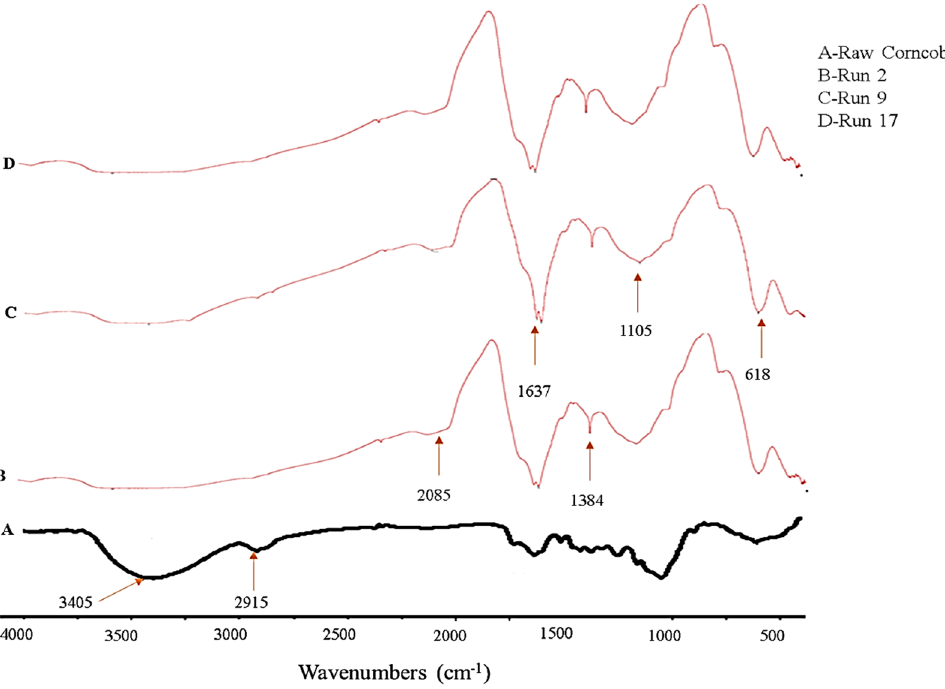
Figure 2. FTIR spectra of raw corncobs and isolated CNCs.